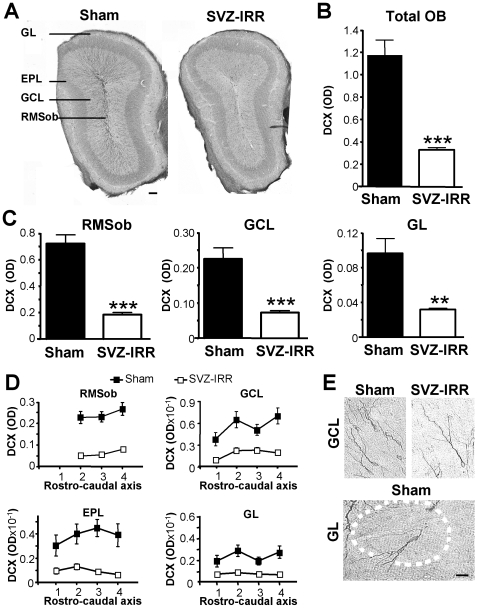
Irradiation decreased the number of DCX+ cells in the OB.(A) Representative images showing DCX+ cells in coronal sections of the OB, 7 months after SVZ irradiation. The GL, EPL, GCL and RMSob are indicated. (Scale bar: 100 µm). (B and C) Densitometric analysis of DCX immunoreactivity in total OB (B), including the RMSob (C, left), GCL (C, middle) and GL, (C, right) of sham-treated and irradiated mice 7 months after irradiation. OD, optical density. Student's t test; *** p<0.0001. ** p<0.01 (n = 12). (D) Densitometric analysis of DCX staining along the rostrocaudal axis of the OB, in sham-treated mice and irradiated mice 7 months after irradiation (n = 12). All cell layers along the entire rostrocaudal axis of the OB were equally affected by SVZ irradiation. (E) Immature neurons visualized by DCX staining in the GCL and GL of sham-treated and irradiated mice, 7 months after irradiation. (Scale bar: 20 µm.)